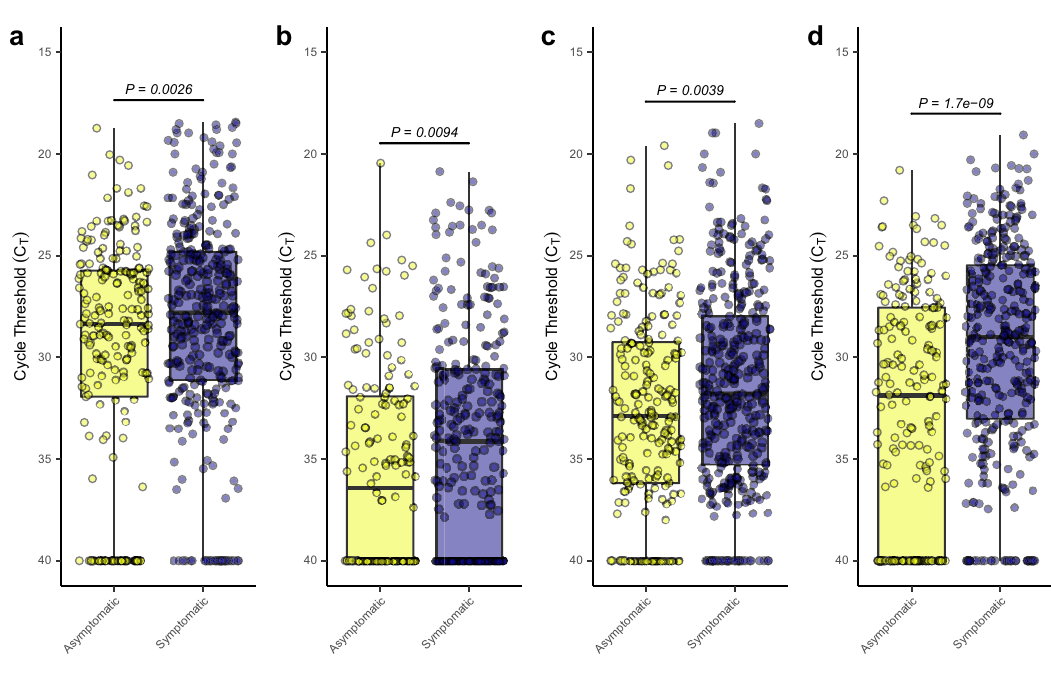
Figure 3. Impact of symptom presence on viral shedding and detection. ( a ) Boxplots of the observed cycle threshold values for active air samples collected by the AerosolSense sampler from rooms occupied by asymptomatic (yellow) and symptomatic (purple) individuals. ( b ) Boxplots of observed cycle threshold values for aerosol particulate samples collected by the AerosolSense sampler, passive air settling plate, and bathroom exhaust vents from rooms occupied by asymptomatic (yellow) and symptomatic (purple) individuals. ( c ) Boxplots of observed cycle threshold values for aerosol particulate samples collected by passive air settling plates and bathroom exhaust vents from rooms occupied by asymptomatic (yellow) and symptomatic (purple) individuals. ( d ) Boxplots of the observed cycle threshold values for environmental swabs collected from the computer, phone, and bathroom floor from rooms occupied by asymptomatic (yellow) and symptomatic (purple)